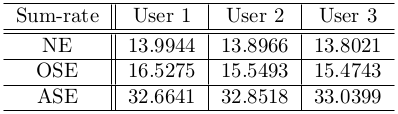
Table from the paper: Self-Optimized OFDMA via Multiple Stackelberg Leader Equilibrium
Table text:
Sum-rate
User1
User2
User3
NE
13.9944
13.8966
13.8021
OSE
16.5275
15.5493
15.4743
ASE
32.6641
32.8518
33.03999